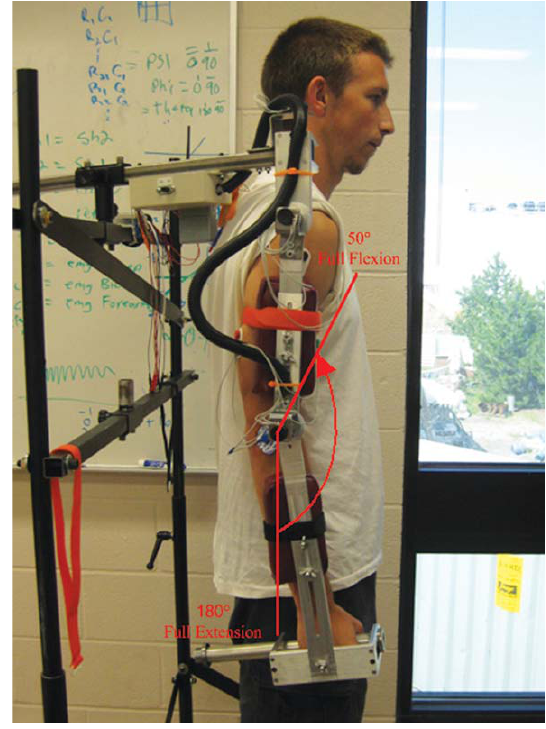
Fig. 4. Range of motion for single joint elbow motion.